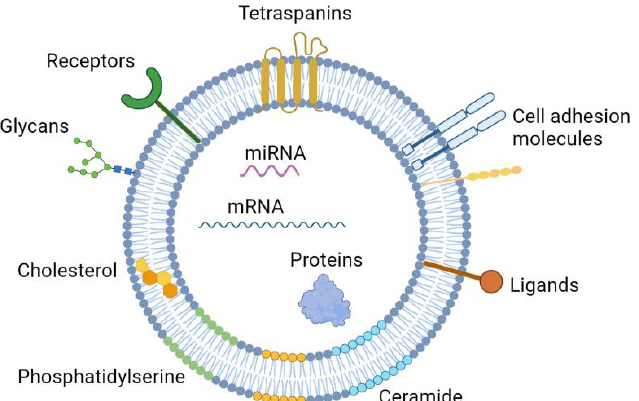
Figure 1. Schematic representation of an extracellular vesicle (EV) and its biological composition. EVs are composed by a phospholipid bilayer membrane enclosing intraluminal fluid with cytoplasmic origin. They contain biomolecules from their cell of origin, which include, other than lipids, several types of proteins (e.g., involved in cell adhesion, as well as other transmembrane and intraluminal proteins with various functions) and nucleic acids (e.g., mRNA and miRNA). Figure created with